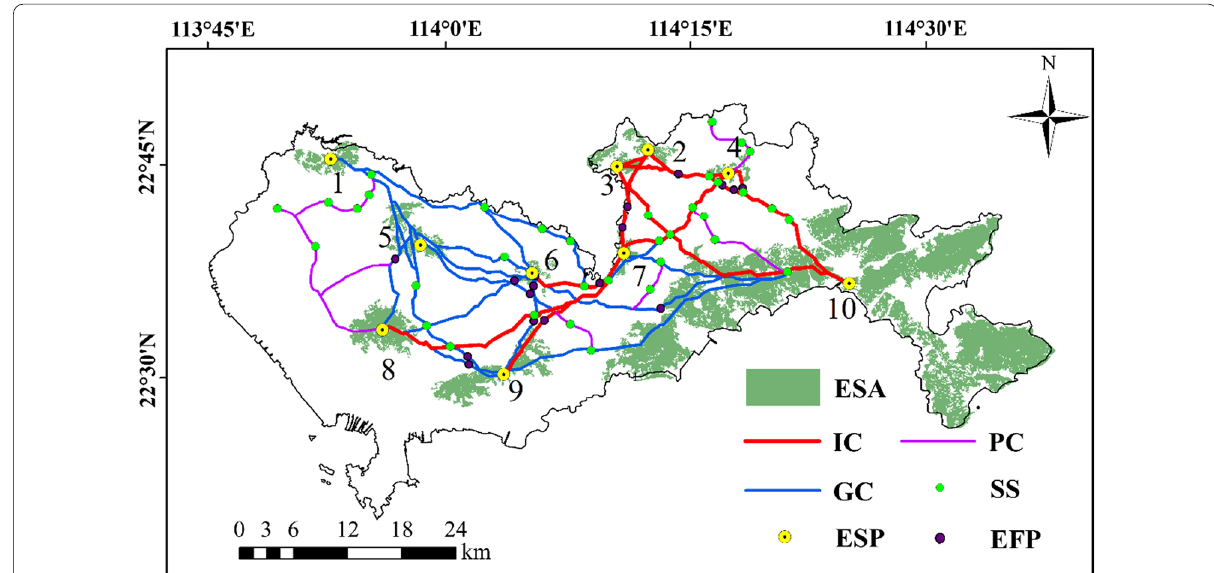
Fig. 7 Optimized ecological networks based on the stepping stones and ecological fault points in Shenzhen City. Numbers from one to ten mark the locations of the ten ecological source points. ESP, ecological source point; ESA, ecological source area; IC, important corridor; GC, general corridor; PC, potential corridor; SS, stepping stone; EFP, ecological fault